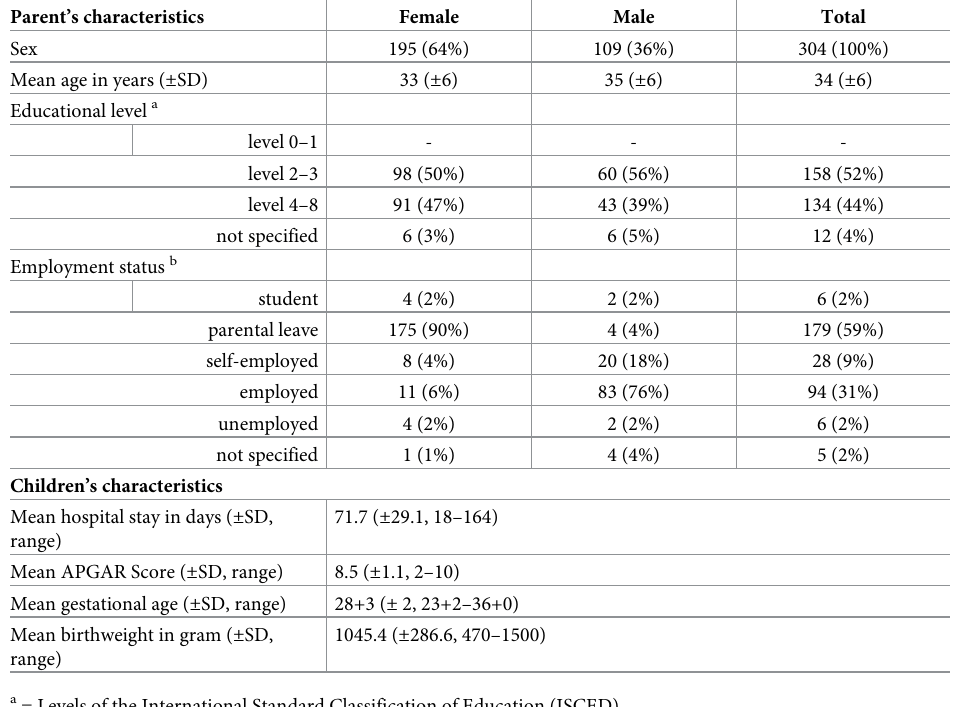
Table 1. Sociodemographic data of